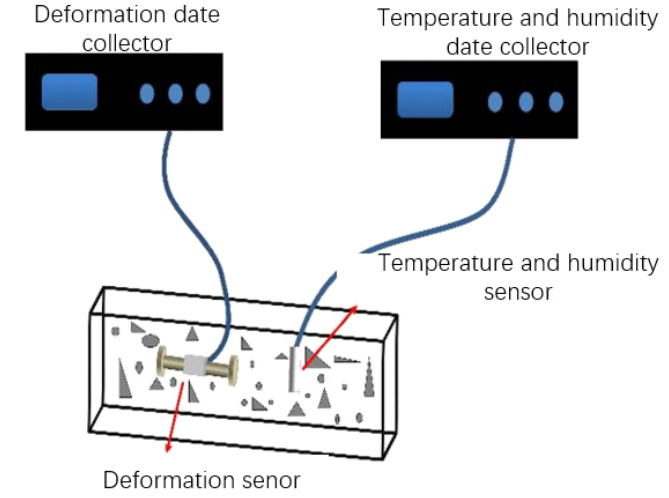
Figure 4. ( a ) Position of concrete strain gauge and temperature and humidity sensor